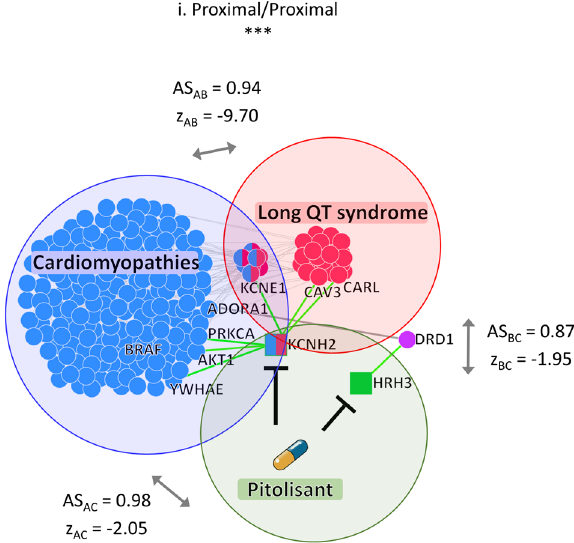
Fig. 7 Interaction network of drug targets inducing severe adverse side-effects. Inferred mechanism-of-action network for a selected triplet: cardiomyopathies (disease A), long QT syndrome (side-effect B), and pitolisant (drug C). The z AC, and z BC denote the z - score normalized values of network proximity between the targets of the drug (C) and the genes associated with the disease (A) and with the side-effect (B), respectively; while z AB denotes the z -score normalized value of network proximity between the genes associated with the disease (A) and with the side-effect (B). AS AC , AS BC , and AS AB are the corresponding adjusted similarity values. In the interaction network, red circles refer to side-effect-associated genes, blue circles refer to disease-associated genes, squares refer to drug targets (blue and/or red colored if they are shared with the disease and/or side-effect module), and violet circle refers to a fi rst nearest neighbor (that is not disease or side-effect-associated gene) of the drug targets able to connect the drug module to the disease module in the human interactome. Green edges refer to connec- tions between the drug targets and their fi rst nearest neighbors in the human